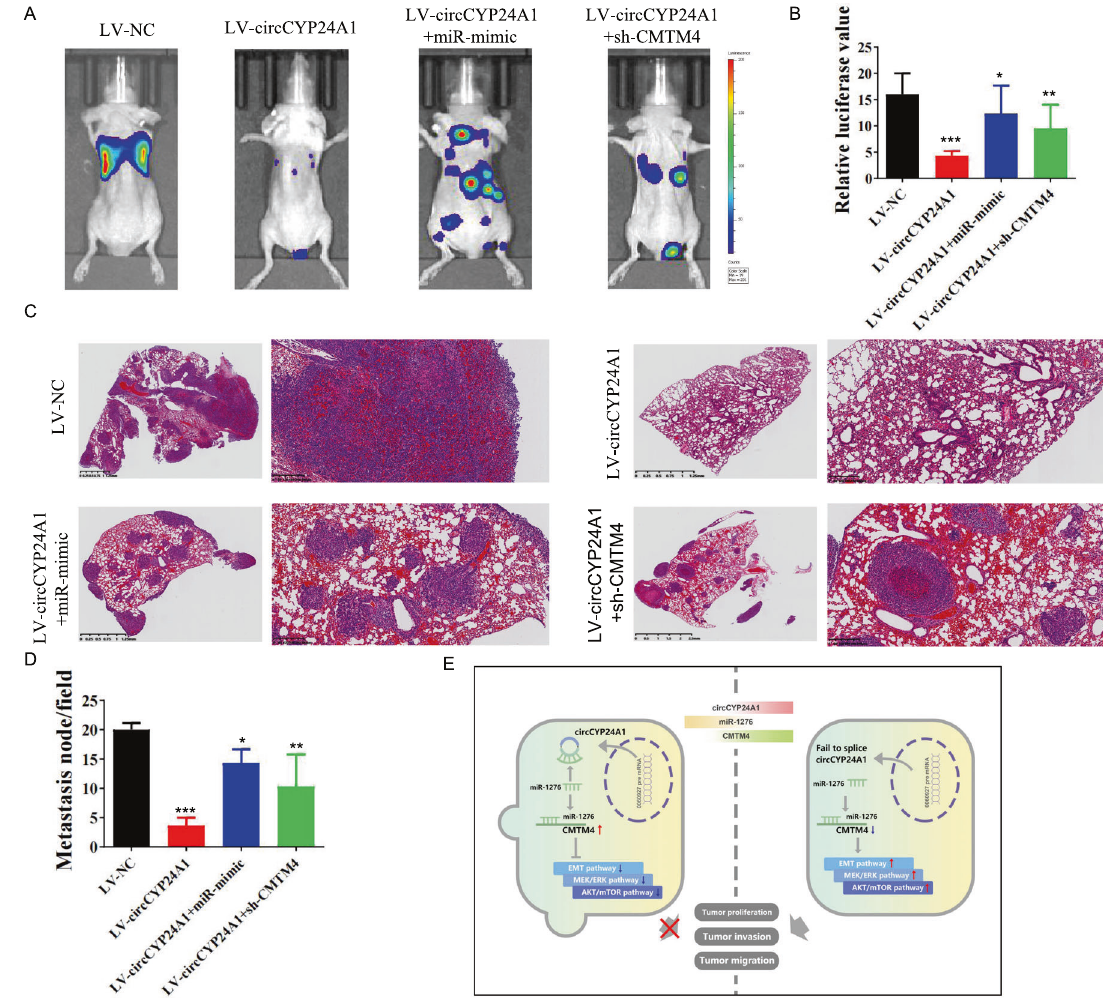
Fig. 8 Overexpression of circCYP24A1 restrains RCC metastasis. A Bioluminescence imaging showed the RCC metastasis sites in the lungs of mice implanted with 786-O cells transfected with LV-NC, LV-circCYP24A1, LV-cirCYP24A1 + miR-421 mimic, and LV-circCYP24A1 + sh-CMTM4 ( N = 5). B Relative luciferase values of 786-O metastatic lesions in the lung were assessed 21 days after intravenous injection. C Representative images of hematoxylin and eosin staining of lung metastasis sites are illustrated. D Metastatic nodules of RCC were analyzed in the 4 groups. E Schematic diagram of the function of circCYP24A1/miR-421/CMTM4 in